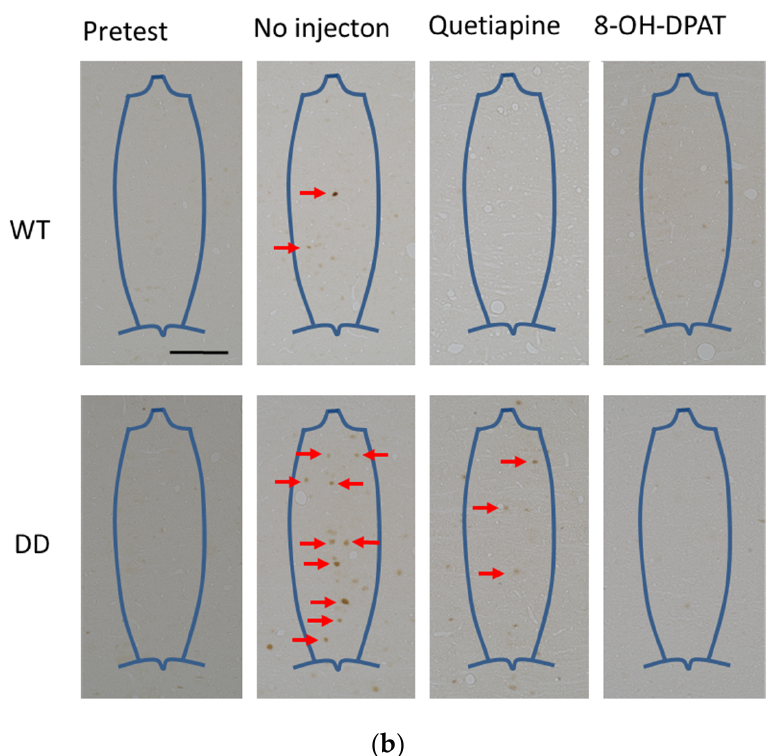
Figure 5. Neuronal activity after quetiapine and 8-OH-DPAT administration in the median raphe nucleus in DD mice. ( a ) number of Fos-positive cells per 0.04 mm 2 in the median raphe nucleus before and 1 h after quetiapine and 8-OH-DPAT administration in WT and DD mice. * p < 0.05, ** p < 0.01, compared with no injection (Scheffé test); ## p < 0.01, compared with WT (Scheffé test). The data are expressed as mean ± SEM. ( b ) Representative immunohistochemical images before and 1 h after quetiapine and 8-OH-DPAT administration in WT and DD mice. Scale bar = 100 μm. Fos-positive cells are indicated by arrows. The blue line depicts the shape of the MRN. 8-OH-DPAT, 8-hydroxy-2-dipropylaminotetralin hydrobromide; WT, wildtype mice; DD, dopamine-deficient mice.